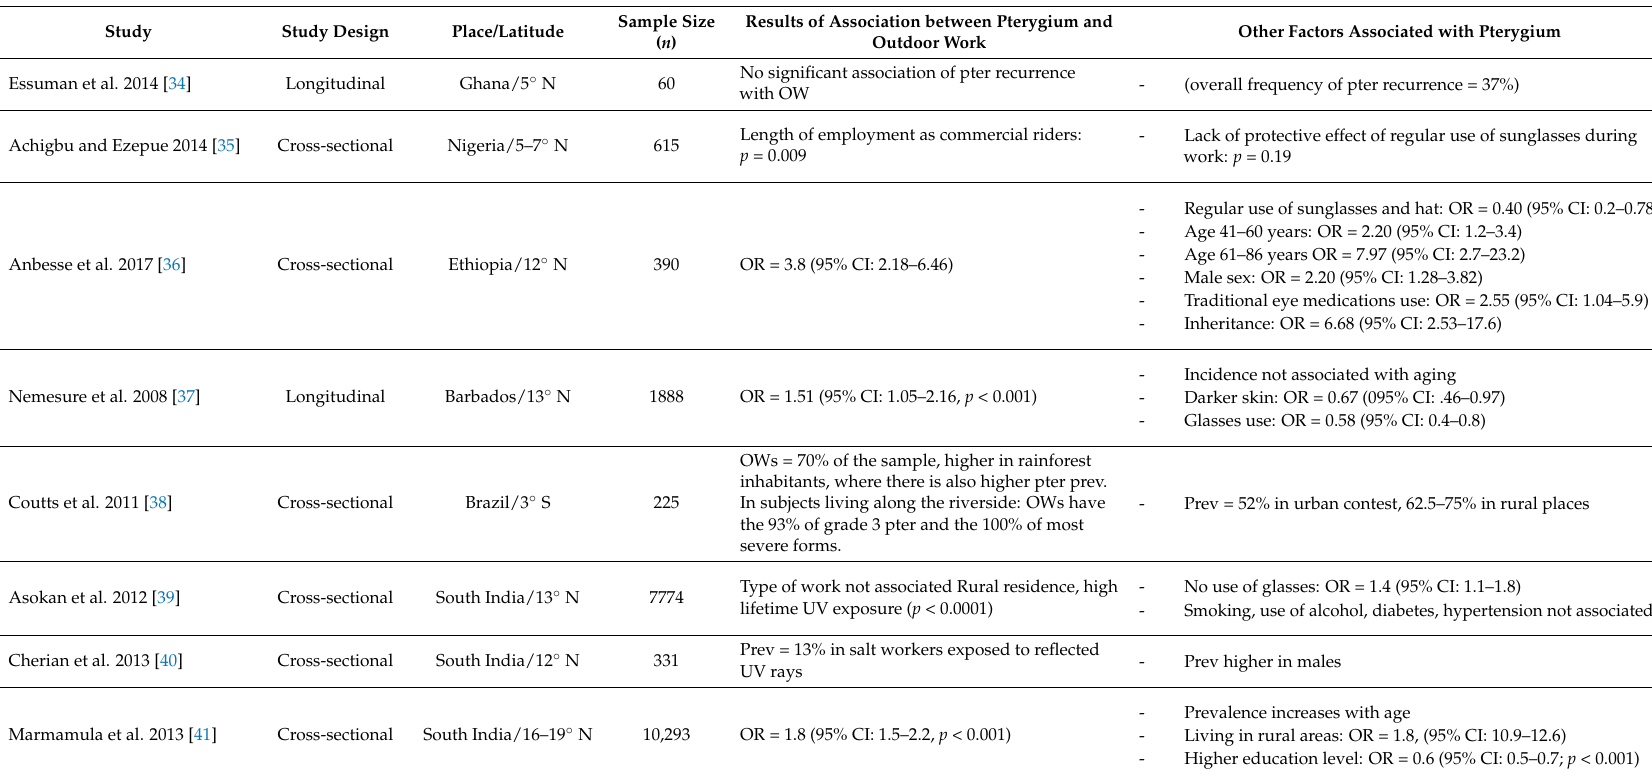
Table 5. Synthesis of the studies on occupational solar UV radiation exposure and pterygium included in the systematic review of scientific literature published in the period 2008–2017 performed in World areas at extremely high risk considering the mean annual UV index